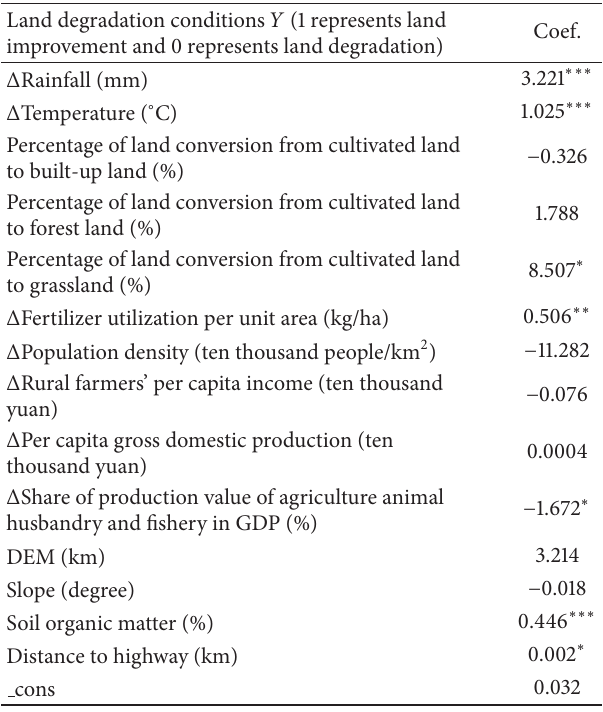
Table 1: Results for binary panel logistic regression analyses for the biophysical and socioeconomic driving forces of land degradation. Land degradation conditions 𝑌 (1 represents land improvement and 0 represents land degradation)